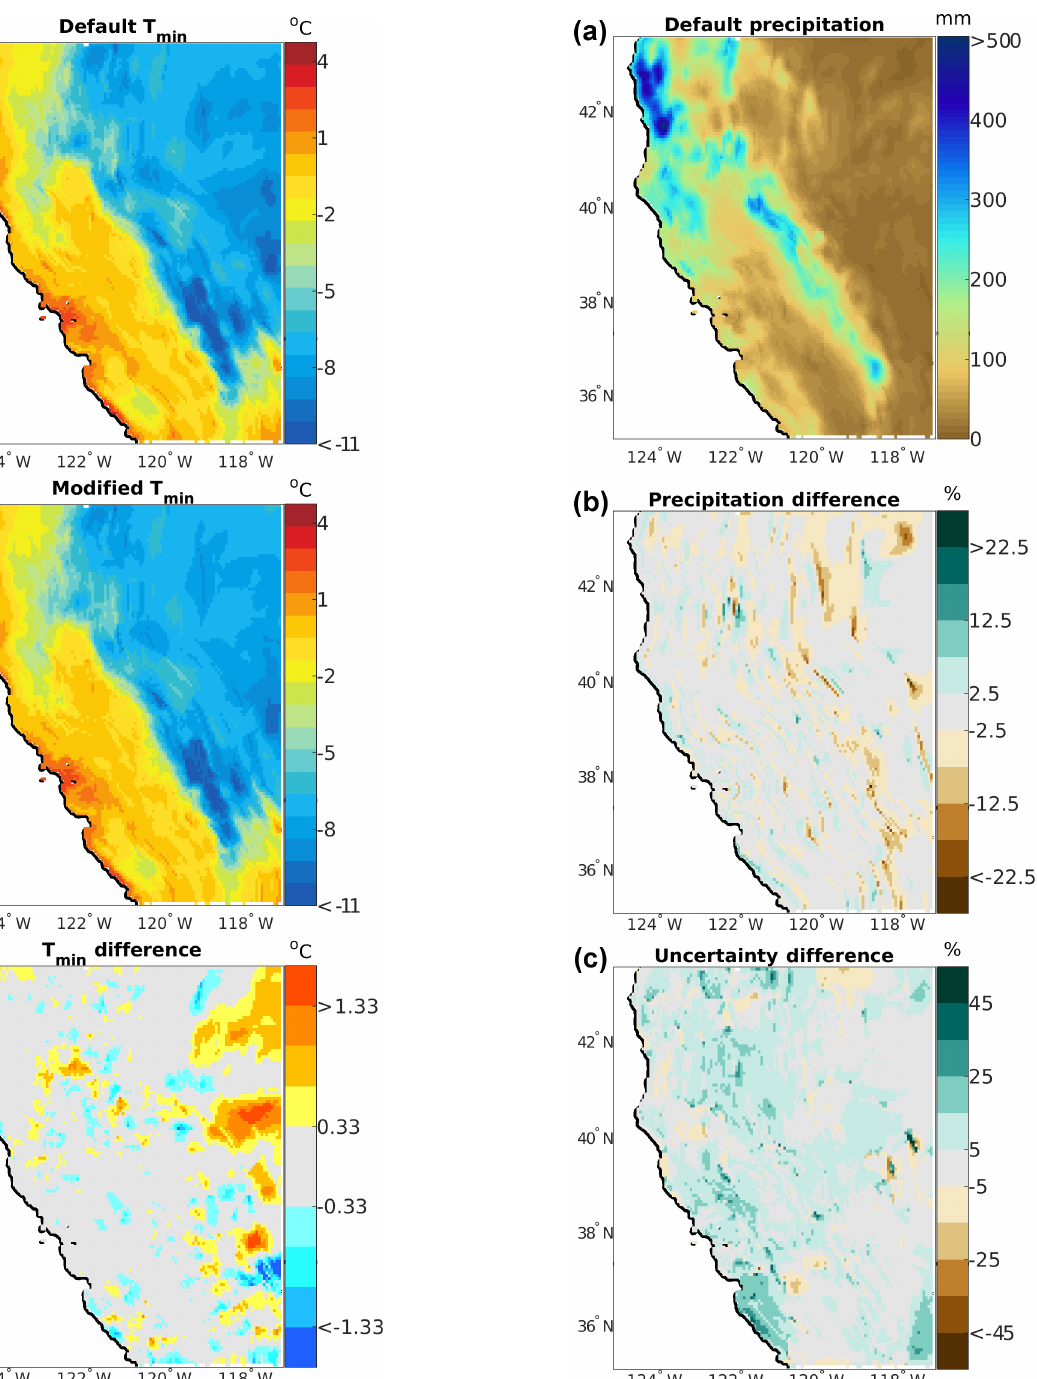
Figure 10. Spatial distribution of (a) base precipitation (mm) for model parameter sensitivity experiment 2, (b) default – modified precipitation difference (mm), and (c) default – modified uncer- tainty difference